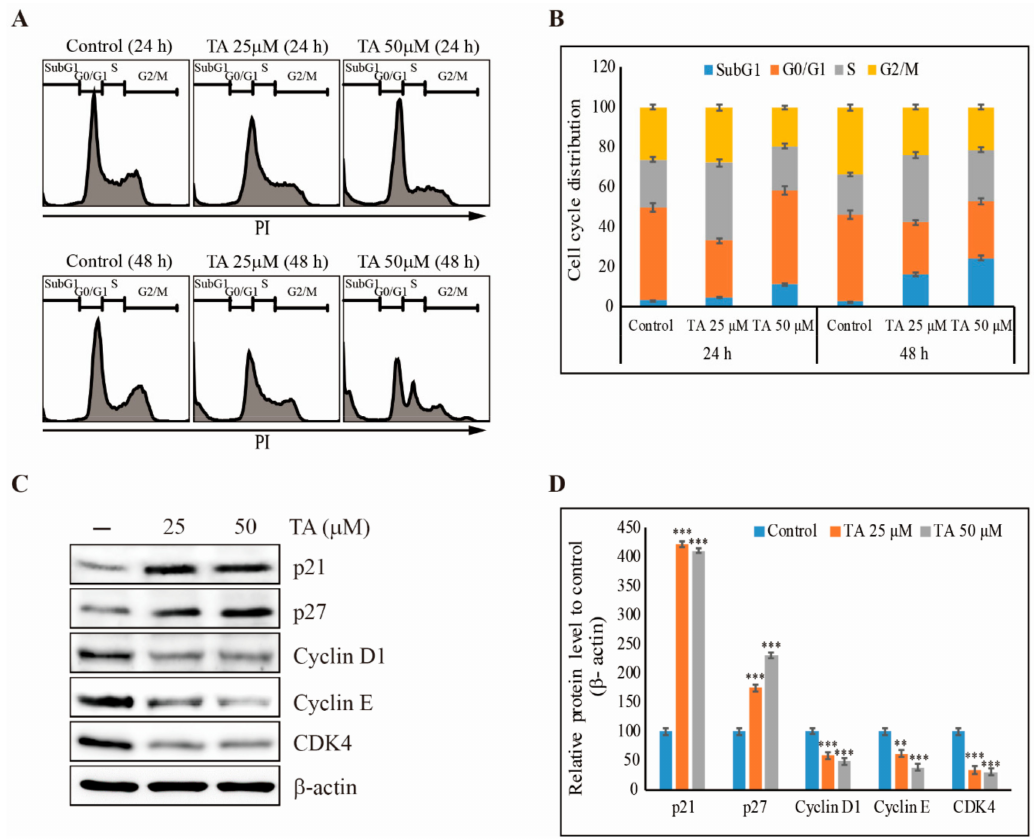
Figure 3. TA induces cell cycle arrest in NCCIT cells. ( A ) Flow cytometry analysis showing sub-G1 arrest after treatment with 25 µ M and 50 µ M TA for 24 h and 48 h in NCCIT cells. ( B ) Graphical representation of the cell distribution in the sub-G1 phase. Experiments were repeated three times, and mean values are presented in the final graph. ( C ) Western blotting analysis of cell cycle markers after treatment with TA for 48 h. ( D ) The representative expressions of the p21, p27, cyclin D1, cyclin E, and CDK4 proteins were determined by densitometry and normalized to β -actin. Controls are set to 100. ** p < 0.01 and *** p < 0.001 ( t